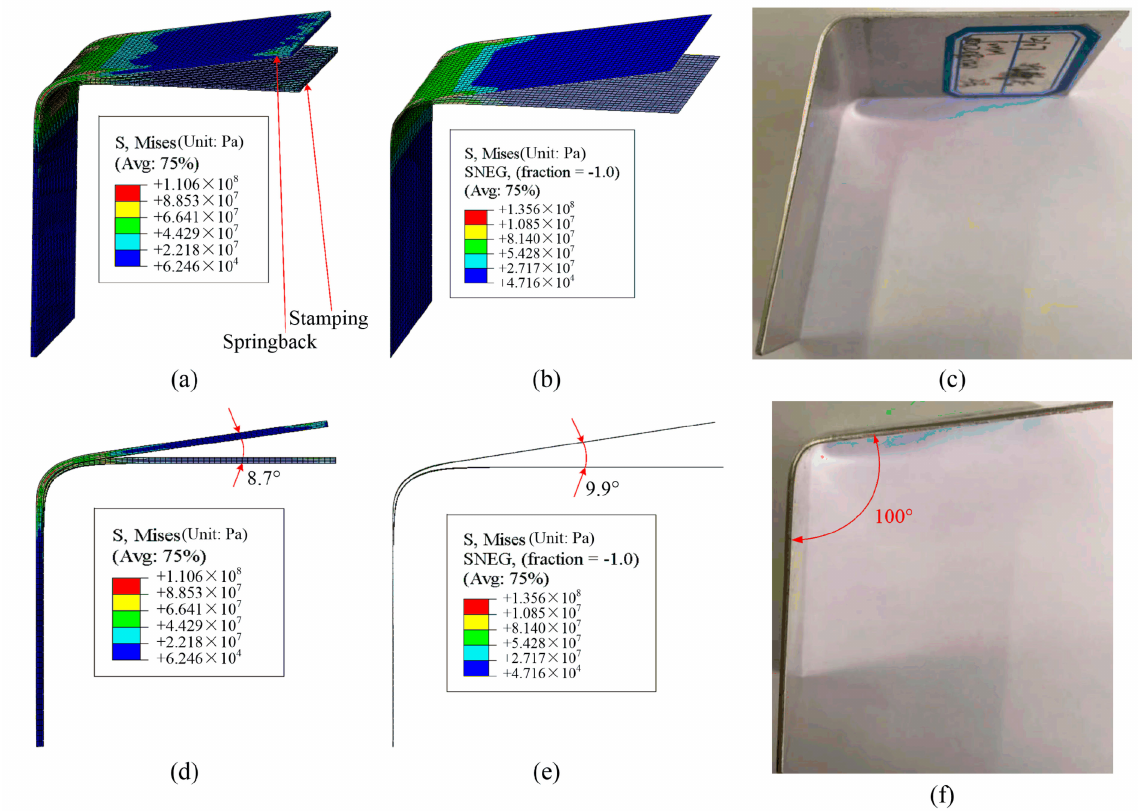
Figure 5. Simulation and experimental results for springback angle: three-dimensional view ( a–c ) and two-dimensional view ( d–f ) using the solid element ( a,d ), shell element ( b,e ), and by experiment ( c,f